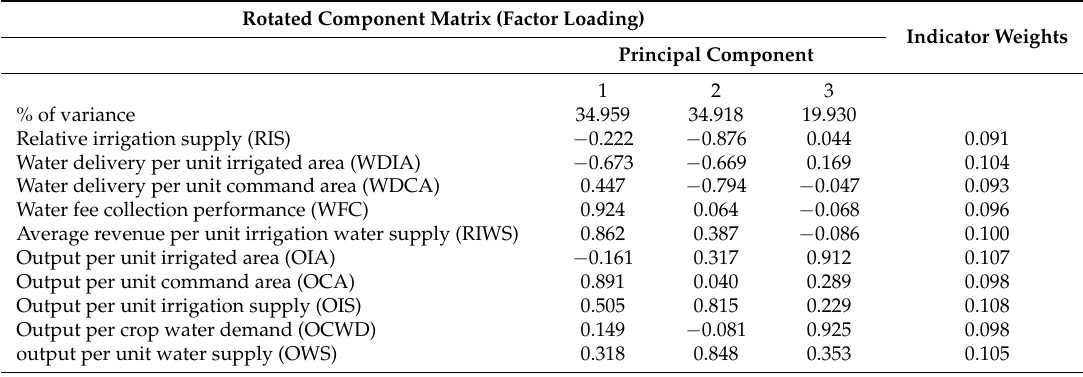
Table 11. The extracted principal components. Rotated Component Matrix (Factor Loading)